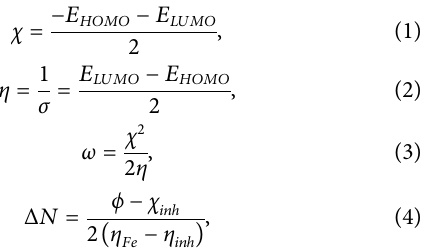
Figure S1 (Supporting data). The fatty acid peaks are in agreement with the distinctive peaks described previously (Shapaval et al., 2014). The peak at ≈ 1706 cm − 1 is